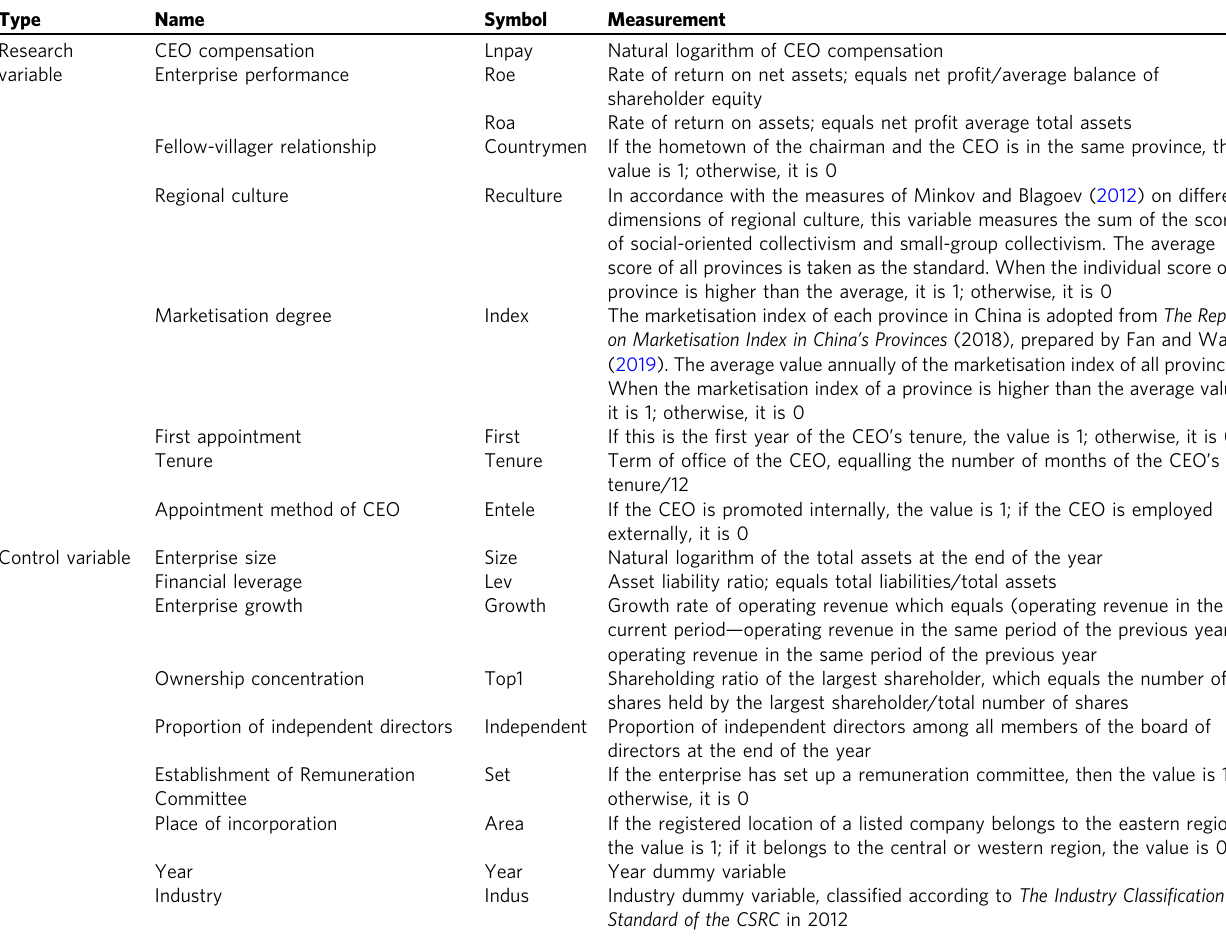
Table 2 Summary of variables.